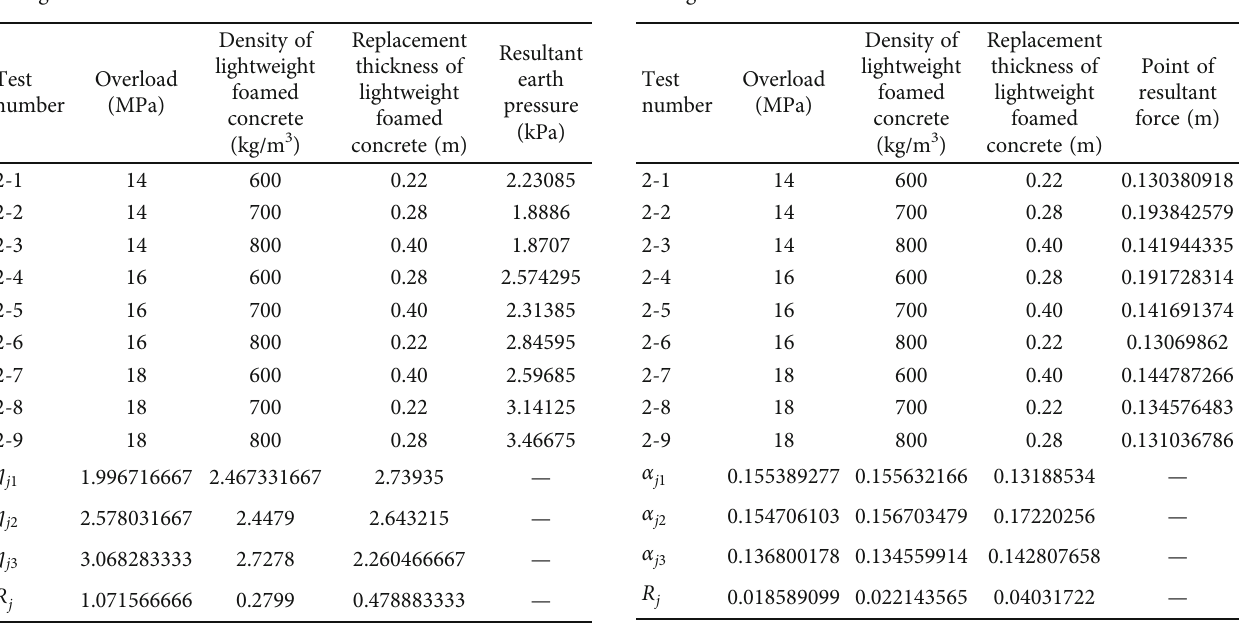
Table 7: Results of resultant earth pressure by multiple-factor orthogonal tests.